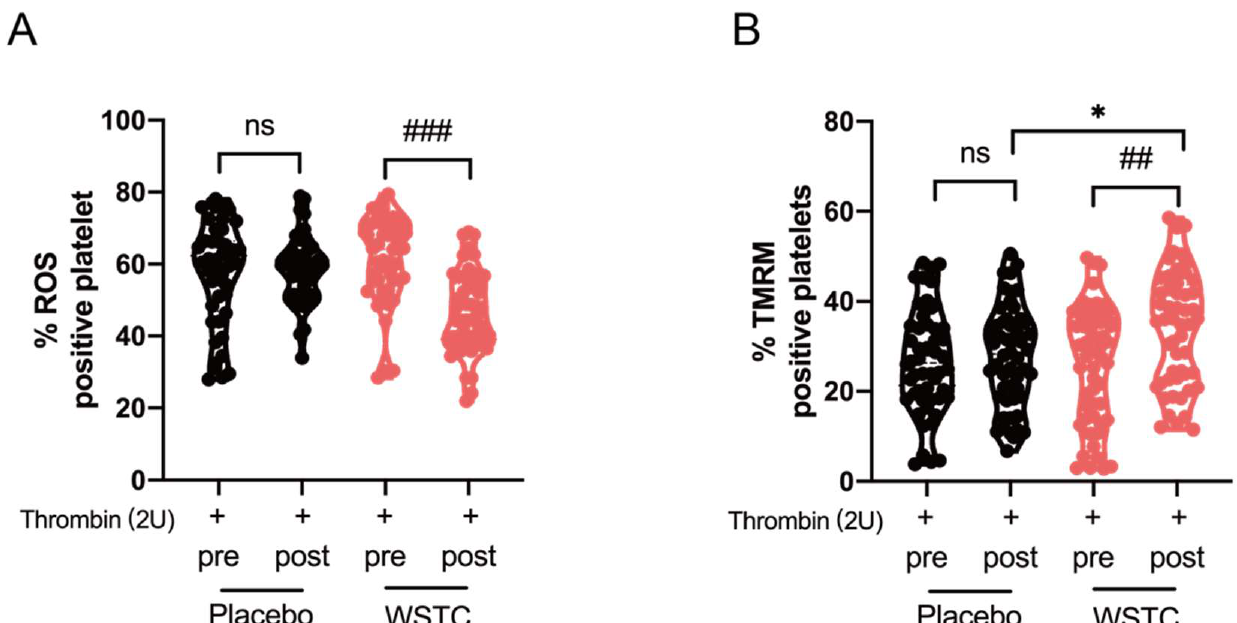
Figure 5. Effects of WSTC supplementation on ∆Ψ m dissipation and ROS in response to thrombin. Human wash platelets were prepared from volunteers before (pre) and after (post) 4 weeks of WSTC or placebo consumption. ( A ) H2DCF-DA-treated platelets were incubated with thrombin (2 unit), and ROS were measured by flow cytometry. ( B ) The wash platelets were incubated with thrombin (2 unit), and TMRM was used to detect ∆Ψ m measured by flow cytometry. At baseline, there was no significant difference in any variable about ∆Ψ m dissipation and ROS between the two groups. * p < 0.05, one-way analysis of variance for independent data was used for comparison between the two groups after 4 weeks of intervention. ## p < 0.01 and ### p < 0.001 vs. baseline in the WSTC group, assessed by a paired Student’s t -test. Abbreviations: ROS, reactive oxygen species and WSTC, water-soluble tomato concentrate.